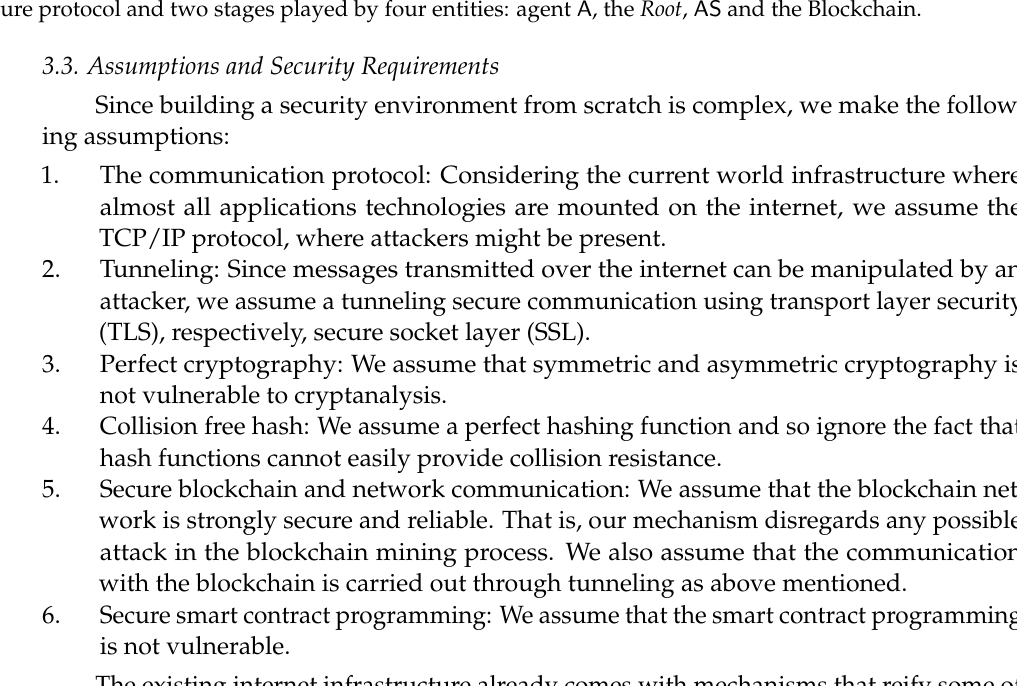
Figure 2. Architecture protocol and two stages played by four entities: agent A , the Root , AS and the